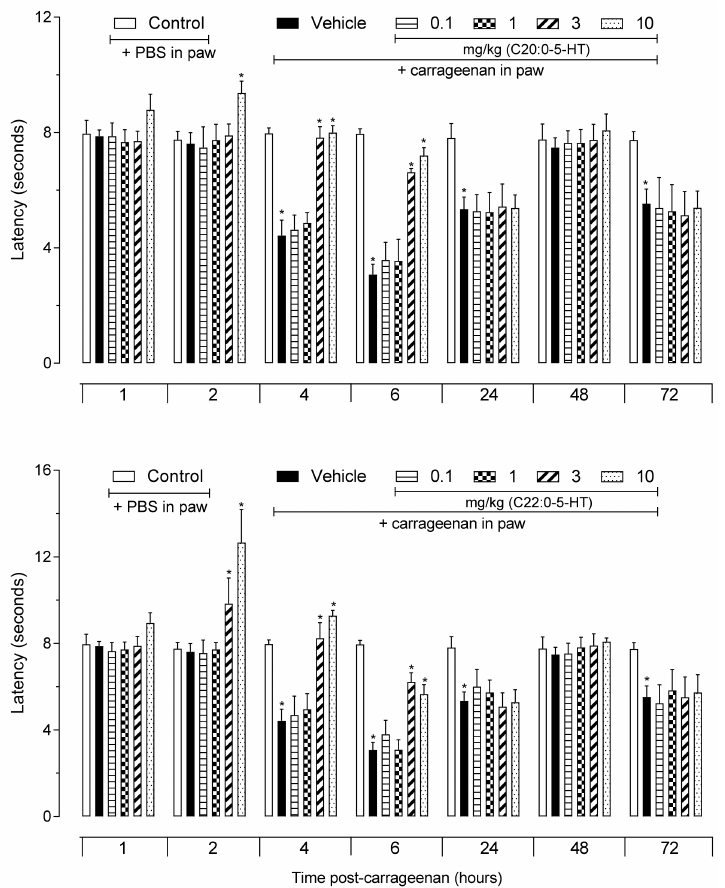
Figure 5. Antihyperalgesic effect of β N -arachinoyl-5-hydroxytryptamide (C 20:0 -5HT) and β N - behenoyl-5-hydroxytryptamide (C 22:0 -5HT). C 20:0 -5HT or C 22:0 -5HT were administered 60 min before the intraplantar injection of carrageenan (25 µ L, 2%). Nociception was evaluated at each time point indicated using the hot plate system. The results are presented as mean ± SD ( n = 8). One-way ANOVA followed by Tukey’s post hoc test was used to calculate the statistical significance. * p < 0.0001 comparing the C 20:0 -5HT- or C 22:0 -5HT-treated groups in mice receiving carrageenan in